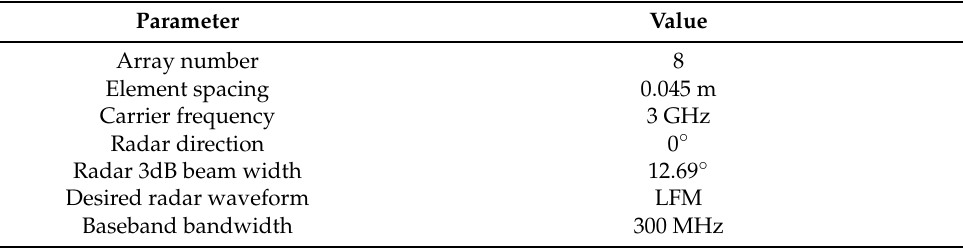
Figure 10. Experimental setup. ( a ) The transmitting array connects with the transceiver system. ( b ) Setup of the transmitting array and receiving antenna. Table 3. Simulation